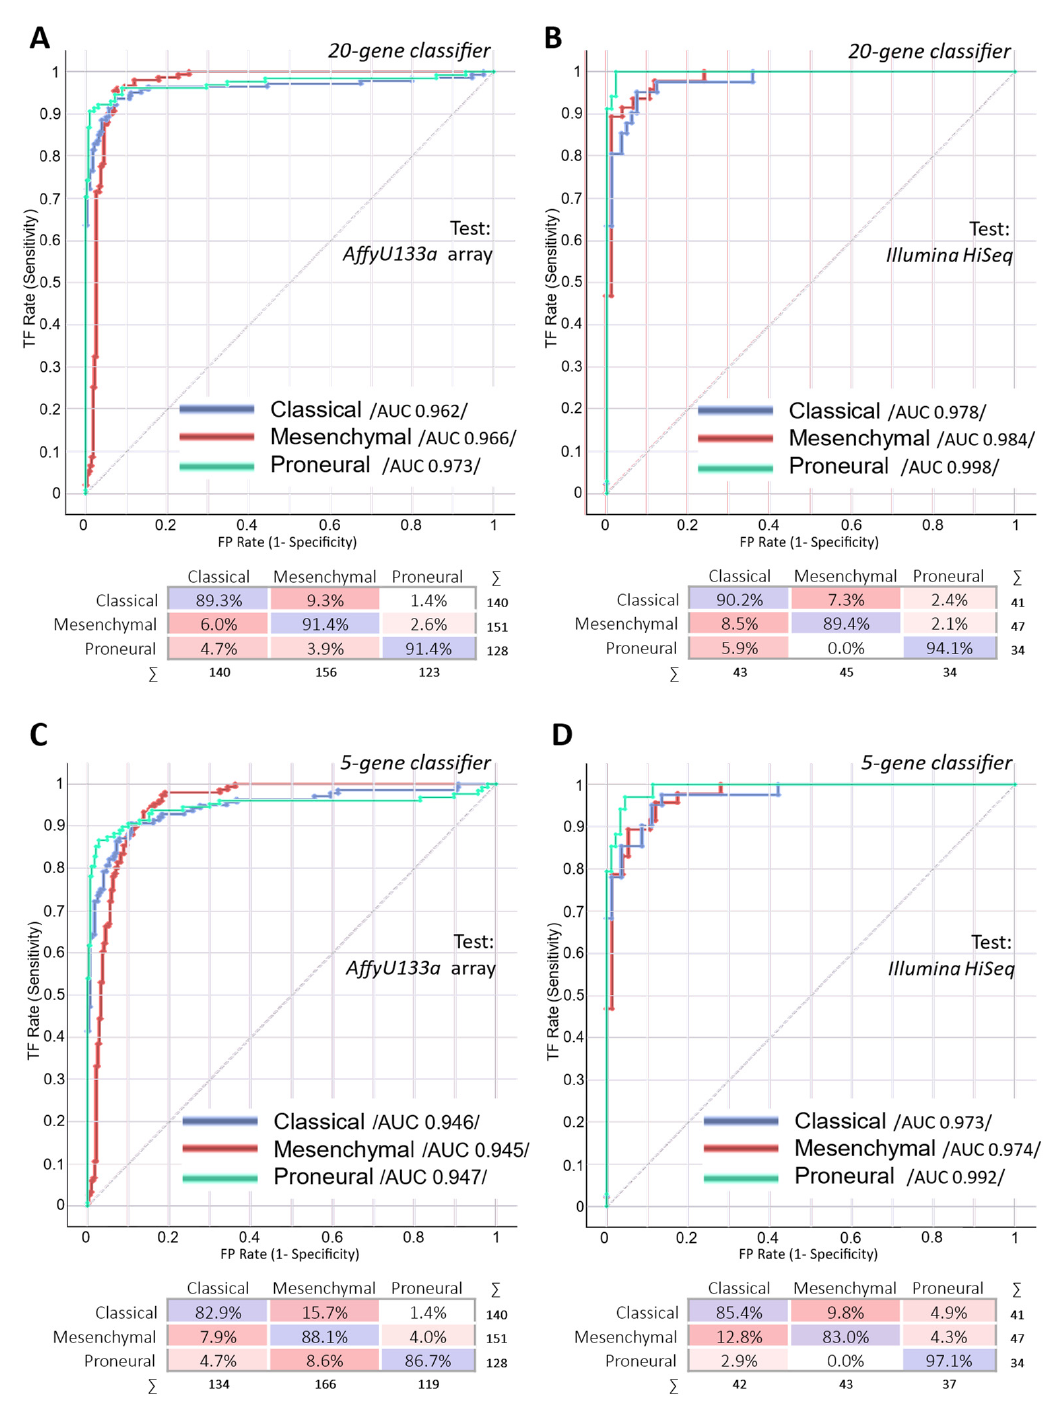
Figure 2. Receiver operating characteristic curves of the 20-gene classifier testing the Affymetrix HT expression array cohort ( A ) and Illumina HiSeq RNA sequencing data cohort ( B ). ROC analysis of the five-gene classifier testing the Affymetrix HT expression array and Illumina HiSeq RNA sequencing data cohorts indicated in parts ( C ) and ( D ), respectively. The matrix at the bottom of each ROC plot specifies the classification accuracy for each subtype.